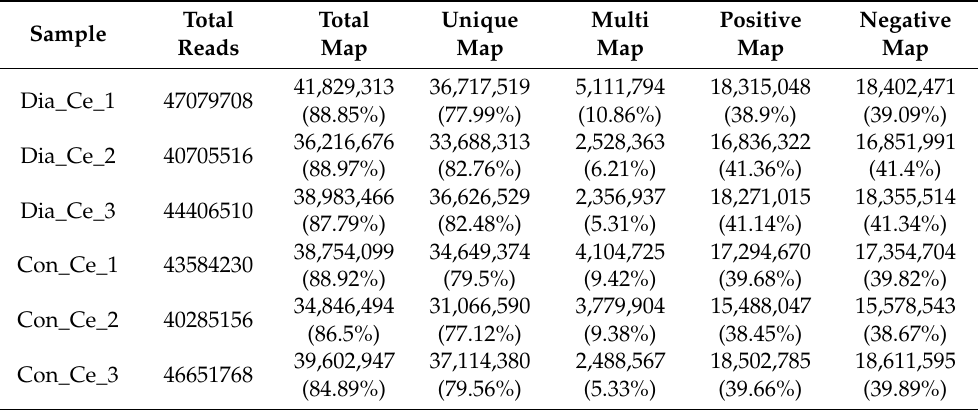
Table 3. Statistical table of comparison results between sample sequencing data and selected reference genome